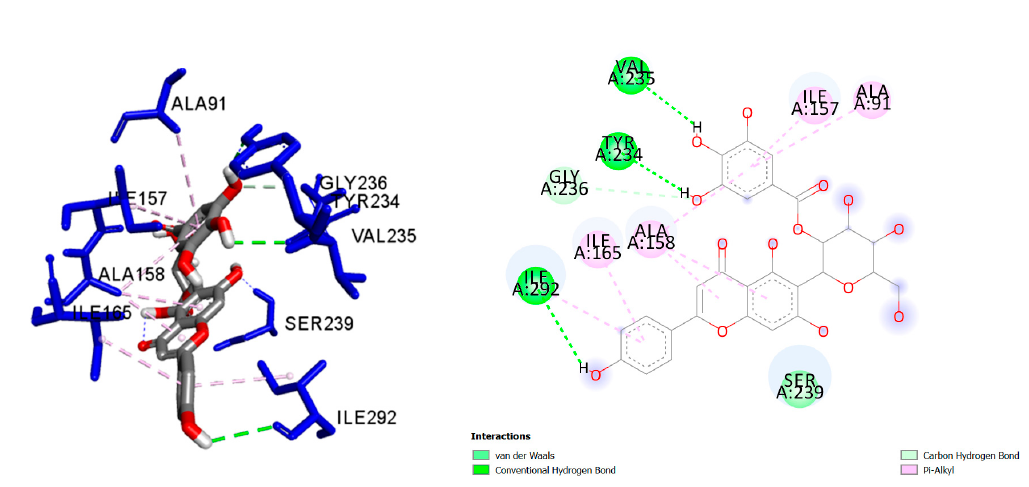
Table 2. Origin of Pelargonium natural products ( 1–10 ), and their predicted free binding energy (docking score Δ G in kcal/mol) and ligand efficiency indices towards Mt PknG a.